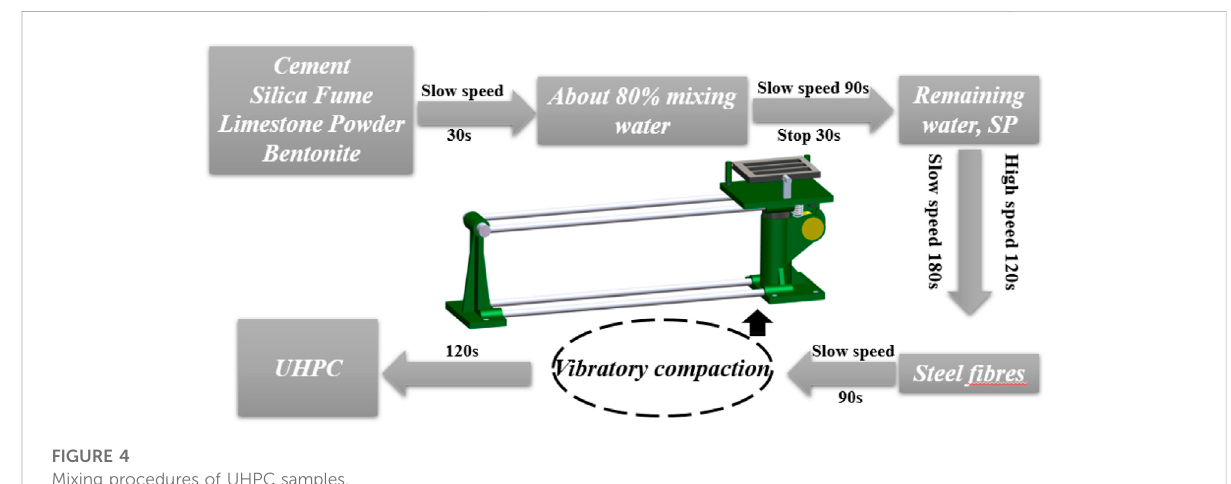
FIGURE 4 Mixing procedures of UHPC